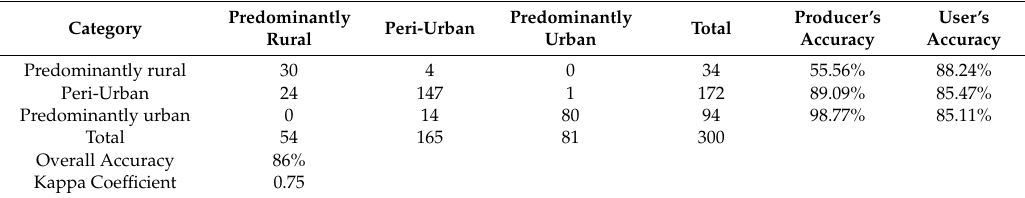
Figure 10. Spatial distribution of ground-truthing points on NTL VIIRS data mapping of 2016 for: ( a ) predominantly rural areas; ( b ) peri-urban areas; ( c ) predominantly urban areas. Table 6. Confusion matrix of NTL VIIRS data mapping of 2016.